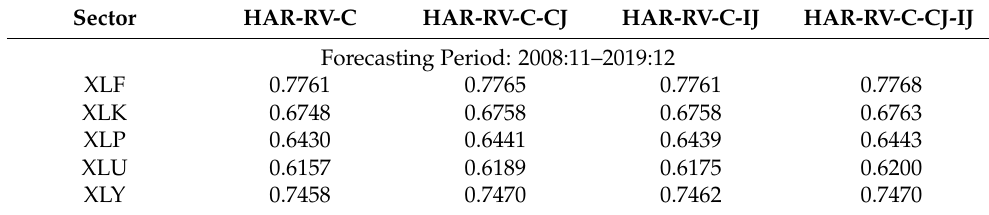
Table 11. In-sample adjusted R 2 *.